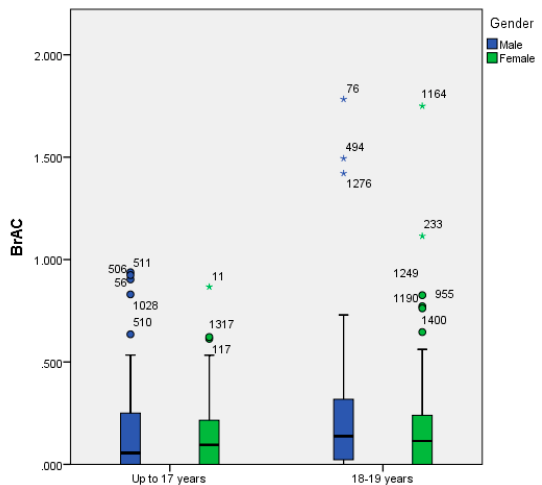
Figure 1. Boxplot of Breath Alcohol Concentration (BrAC) level by age group for alcohol drinking in Spain (up to 17 years of age and 18 or more years of age) and gender (male and female).